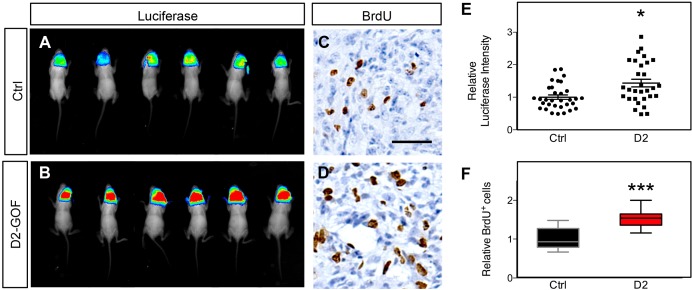
Daam2 accelerates glioma tumorigenesis in PB-Ras model.(A–B) Representative bioluminescence imaging of mice bearing PB-Ras glioma with Daam2 overexpression or control, imaged at 10 days post-natal. Imaging quantification in E is derived from 17 Daam2-overexpression and 20 control mice; *p=0.0019. (C–D) Immunohistochemistry analysis of BrdU expression from mice bearing PB-Ras glioma from each experimental condition. Relative number of BrdU expressing cells is quantified in F and is derived from six total mice, four slides per mouse, from each experimental condition; ***p<0.0001. Scale bar in C is 50 nm. Error bars in E-F are ± SEM.